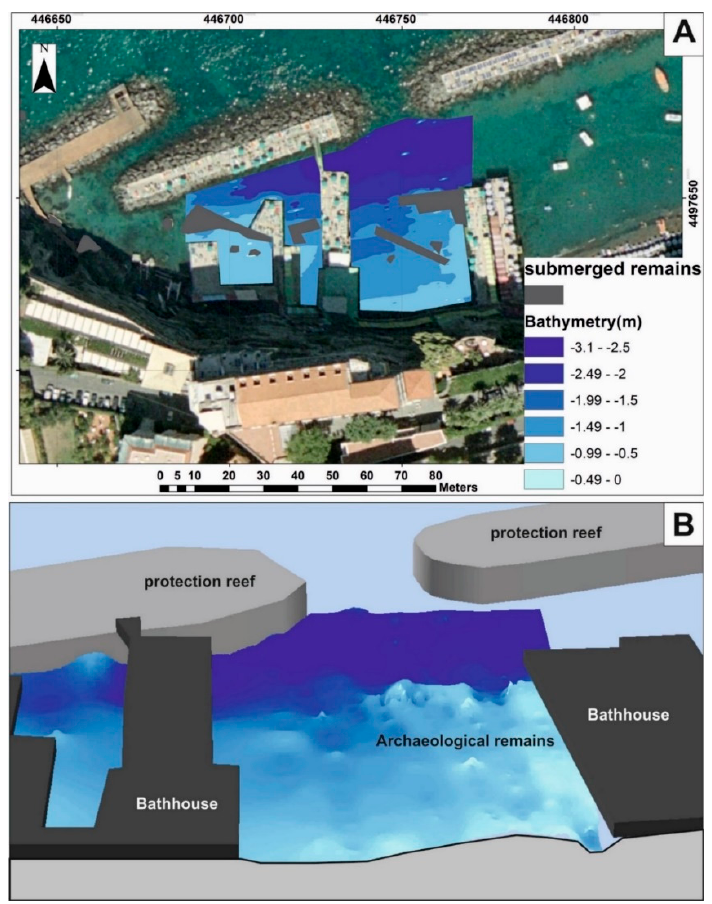
Figure 12. ( a ) 2D visualization of the sea floor digital model of the study area—Sorrento Marina